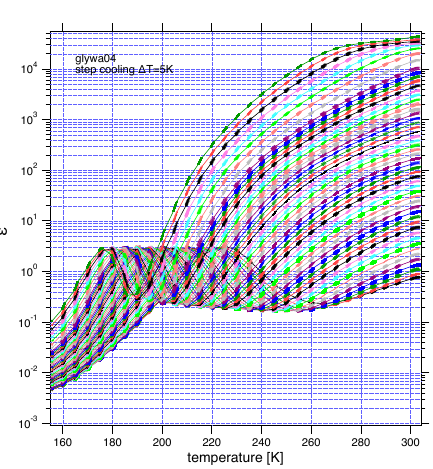
Figure 6. Temperature dependence of the dielectric permittivity of a glycerol-water mixture with a 0.4 molar fraction of glycerol as measured in step cooling.